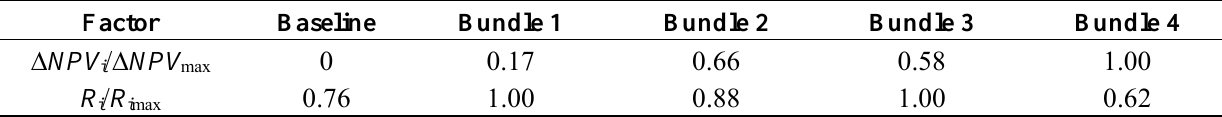
Table 5. Financial and risk performance.